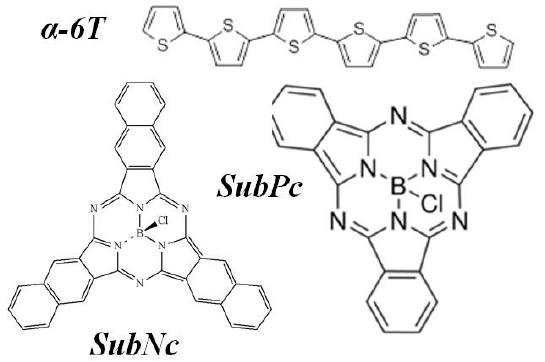
Figure 1. The molecule chemical structure of the used materials and schematic representation of the device structure.